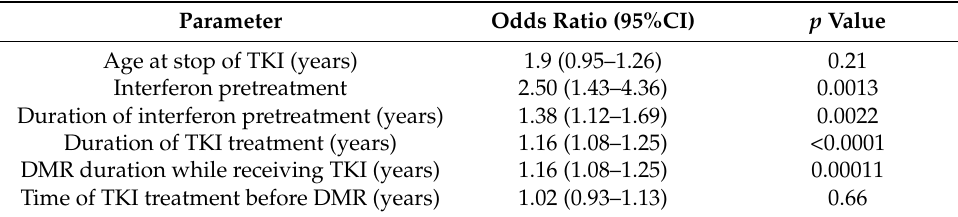
Table 3. Evaluation of the variables associated to 6-month major molecular response after TKI discontinuation; data from EURO-SKI trial ( N =